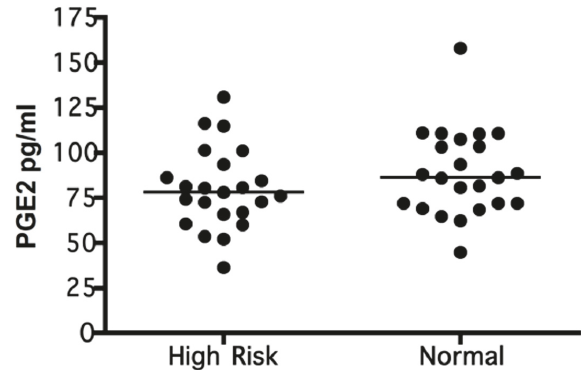
Figure 1: PGE 2 levels by risk. Expression of PGE 2 in case group patientsatriskofpretermdelivery(HighRisk)andthecontrolgroup notatrisk(Normal),n=23pergroup.ThePGE 2 levelswasquantified by ELISA and compared between groups by a bivariate analysis. The data are represented by the median for each group.